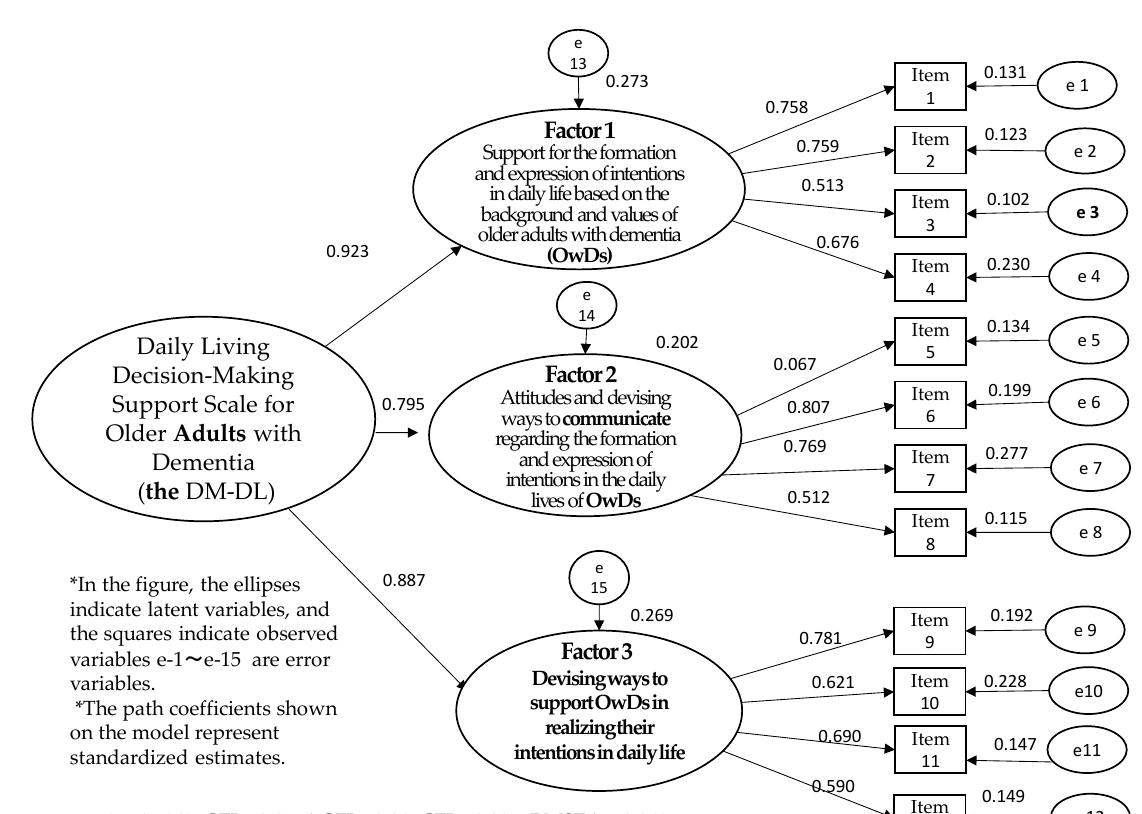
Figure 1 Covariance structure analysis of the Daily Living Decision-Making Support Scale for Older Adults with Dementia (the DM-DL)